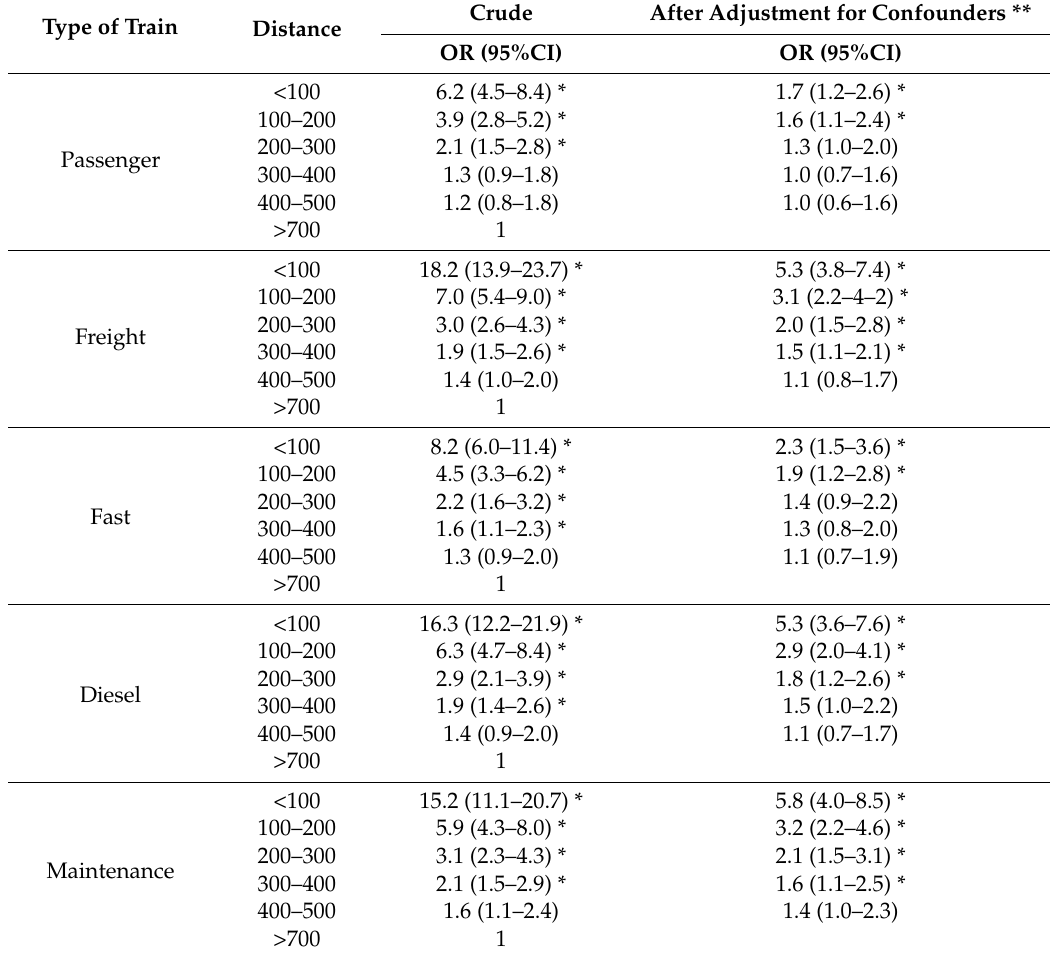
Odds of being annoyed by vibrations stratified by distance and train type with moderating